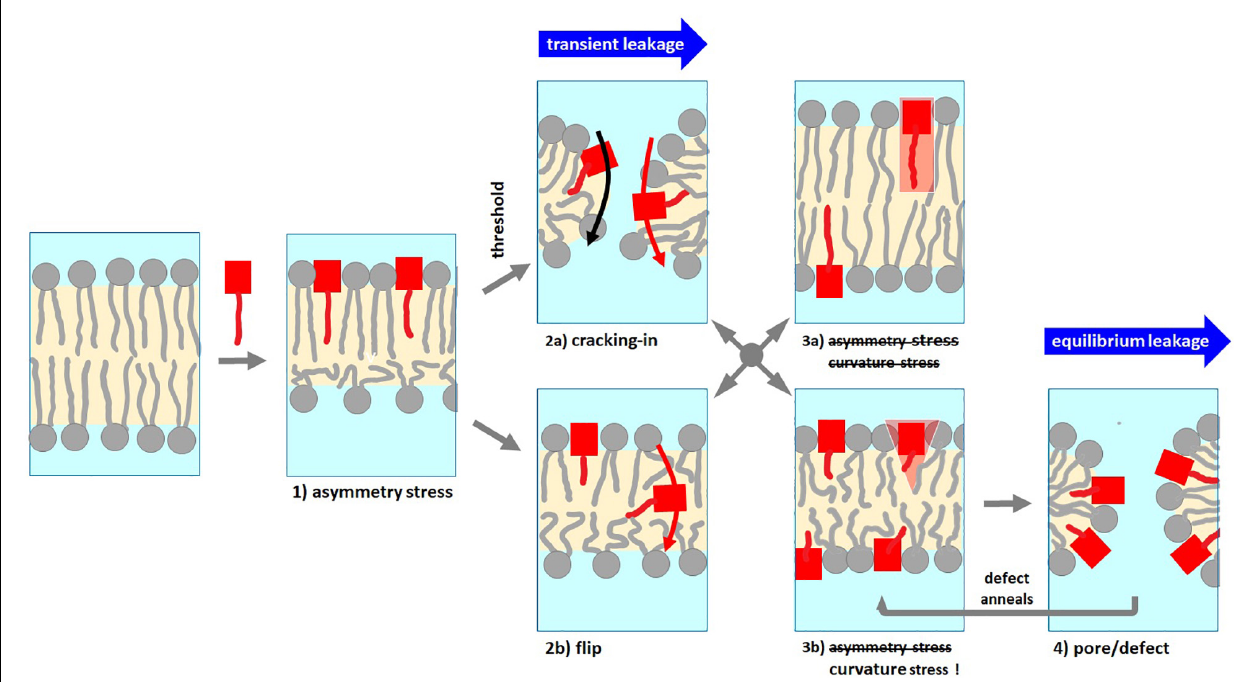
FIGURE 7 | Schematic representation of the expected membrane phenomena and their related modes of action to induce leakage by PSDs. The data suggest PSD-C4 to act by asymmetry stress and to cause transient leakage accompanying its cracking-in (trace 1-2a-3a). Due to its weak membrane partitioning, PSD-C4 fails to reach the local content required to induce pores via curvature stress. PSD-C6 through PSD-12 induce transient leakage translocating PSD into the inner leaflet that gives rise to curvature strain, hence, promotes subsequent equilibrium leakage (trace 1-2a-3b-4-3b-4 etc.). PSD-C14 shows no fast, transient leakage but, after slow flip of some of it to the inner leaflet, equilibrium leakage (trace 1-2b-3b-4-3b-4 etc.). See text for further